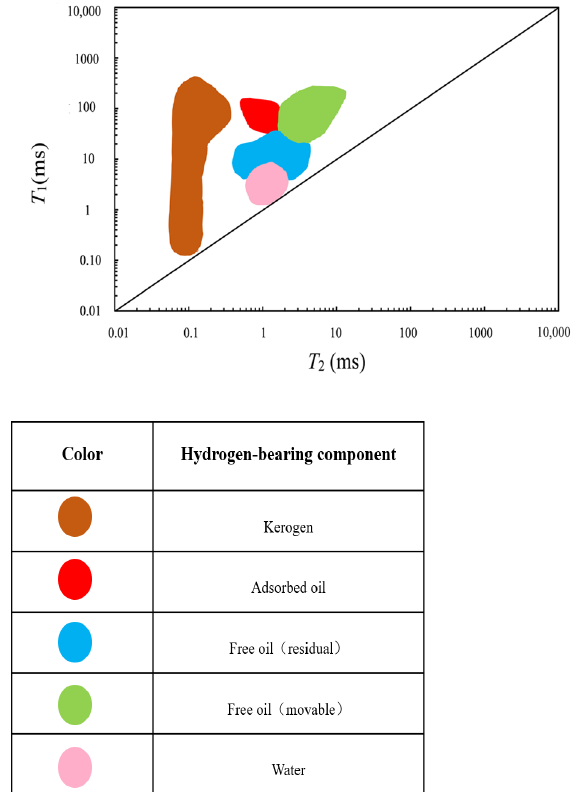
Figure 10. Composition distribution graph of inter-salt shale established in the present study. The graph includes the distribution of free movable oil, free residual oil, adsorbed oil, water, and kerogen. The distribution range of each component is shown in Table 1. Table 1. The distribution range of various components of inter-salt shale.